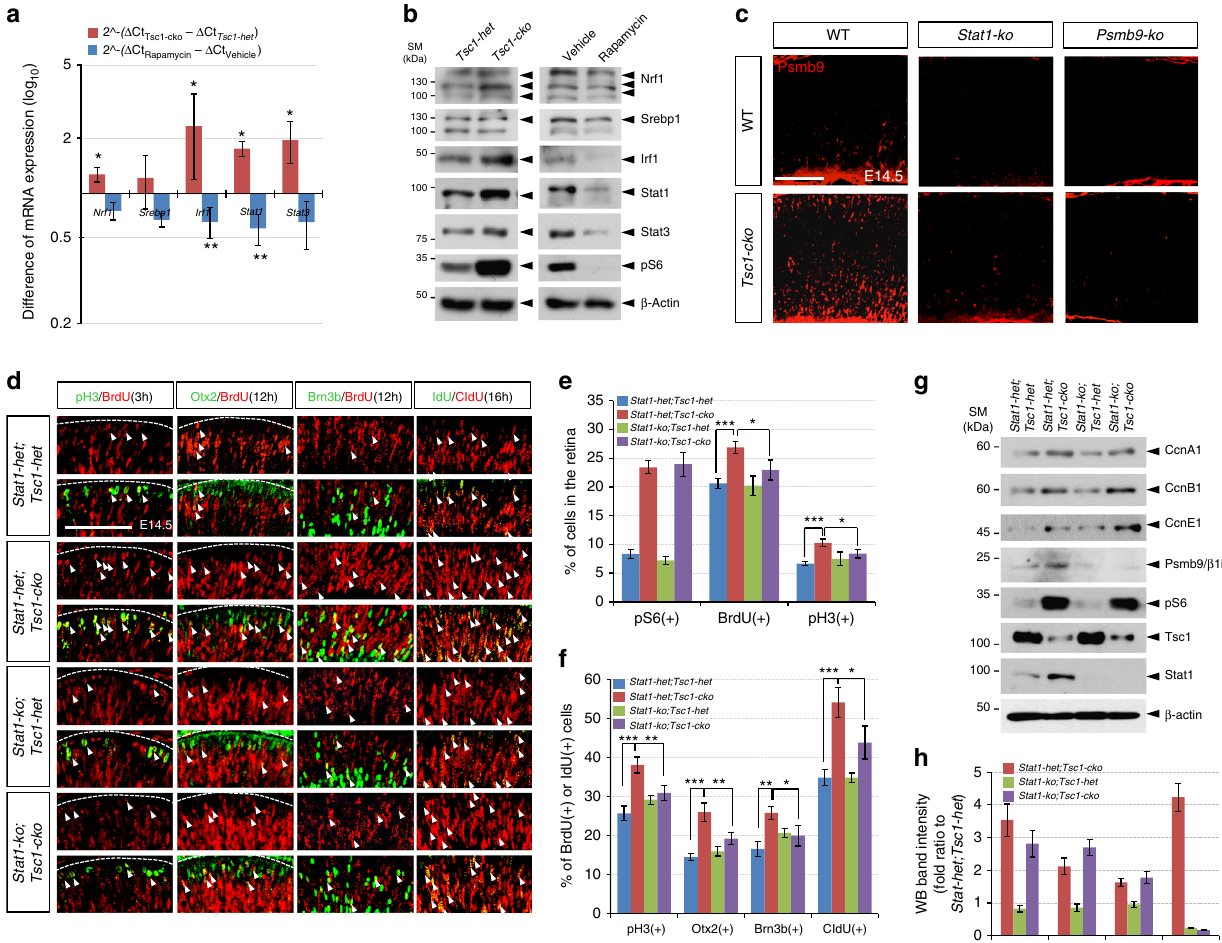
Fig. 8 mTORC1 mediates Stat1 to induce Psmb9 in RPCs. a Relative mRNA levels of transcription factors, which have been known as regulators of proteasome subunit expression 39, 42, 46 , in E14.5 Tsc1-cko and rapamycin-treated mouse retinas were obtained by comparing RT-qPCR values with those of Tsc1-het and vehicle-treated mouse retinas at the same age. Error bars denote SD ( n = 5). b The transcription factor proteins in E14.5 mouse retinas were analyzed by WB with corresponding antibodies. Multiple bands of Nrf1 are products of glycosylation 62 . c Distribution of Psmb9 in E14.5 mouse retinas with indicated genotypes was examined by immunostaining with anti-Psmb9 antibody. Scale bar, 100 μ m. d Cell cycle progression of RPCs in E14.5 mouse retinas with combinatorial Tsc1-cko and Psmb9-ko alleles was examined as described in Fig. 2f. Scale bar, 100 μ m. e Average percentage of cells expressing each marker in the retinas was provided in a graph. f Ratio of BrdU-co-expressing cells to total marker-expressing cells in d was also shown in a graph. Numbers of mice used are 4 and from 3 independent litters; error bar denotes SD. g Retinal cell lysates (20 μ g proteins/lane) obtained from E14.5 littermate mouse embryos were analyzed by WB with corresponding antibodies. h Image pixels of WB bands in each retinal sample were calculated by ImageJ software and relative intensities were obtained by comparing the pixel numbers with those of Stat1-het;Tsc1-het samples. Values are average measurements of 3 independent WB results. Error bars denote SD. P -values are obtained by one-way ANOVA test and shown in the graphs (*<0.05; **<0.01;